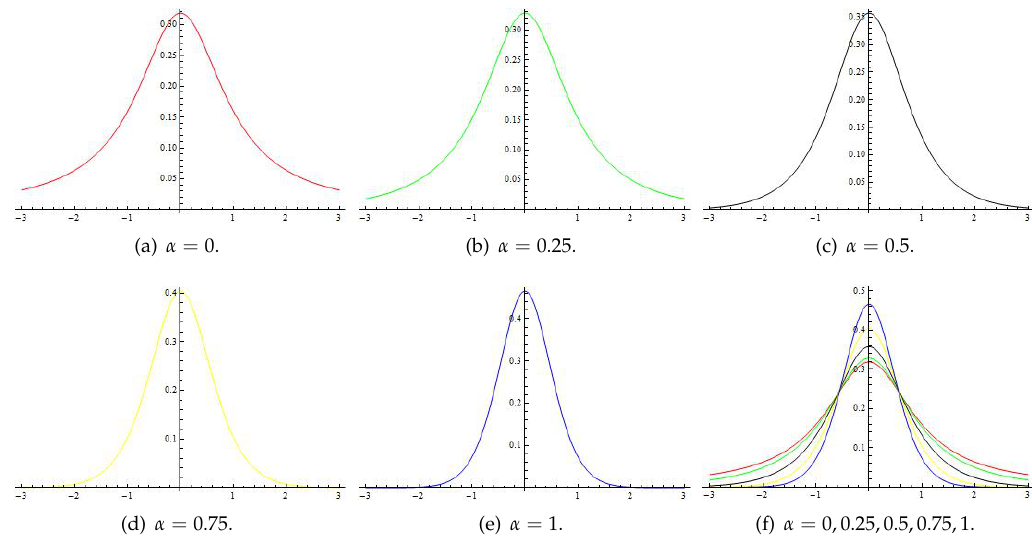
Figure 1. The graphs of the density function f ϑ ( x , α ) with different α